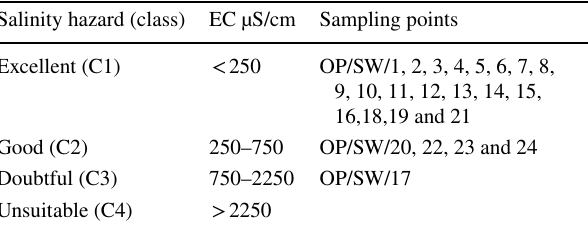
Table 2 Classification of water based on EC (Richards 1967; USDA